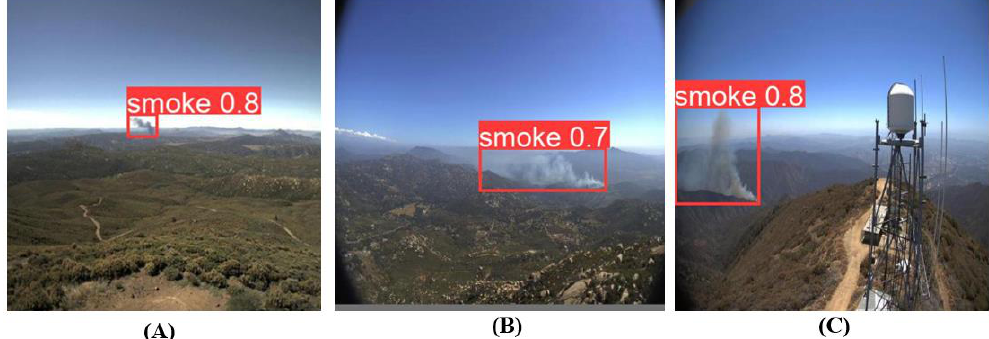
Figure 10. YOLOv5x detection areas results. ( A ) Far. ( B ) Medium. ( C ) Close.